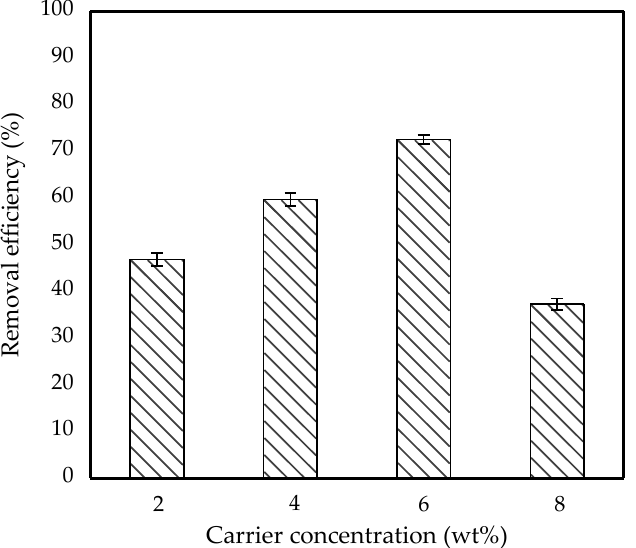
Figure 8. Effect of carrier concentration on removal efficiency of 10 ppm IBP. (Condition: [Span 80] = 6 wt%; Stirring speed = 300 rpm; Emulsification time = 20 min; O/I = 3:1; Kerosene = 30 mL).